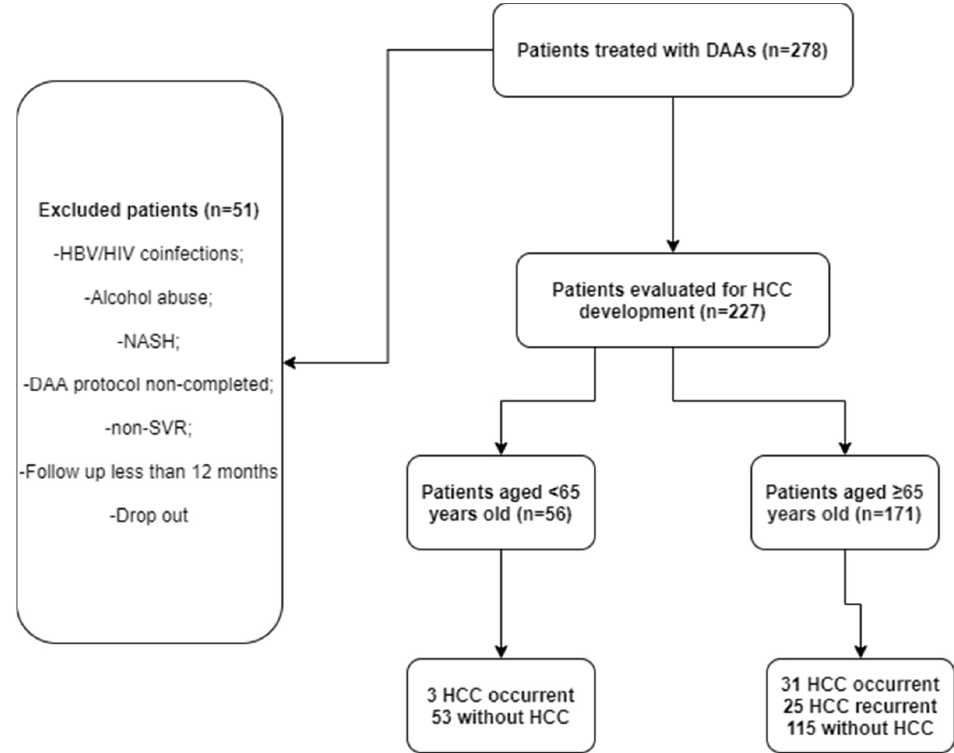
Figure 1. Flow chart of patient selection criteria in this retrospective study. At baseline, data on clinical characteristics and parameters, namely age, sex, anthro- pometric parameters, and comorbidities (ASA score), and extrahepatic diseases (type 2 diabetes, kidney damage, immune-mediated manifestations, cardiovascular disease, obe- sity) were collected.